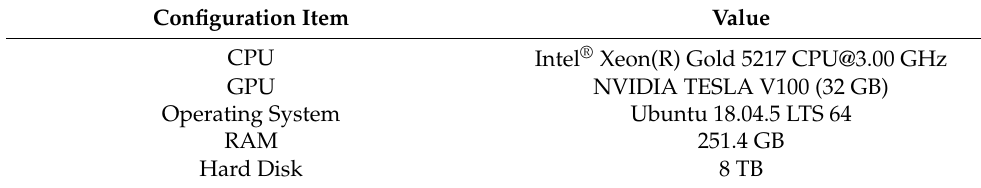
Table 2. Hardware and software environment.